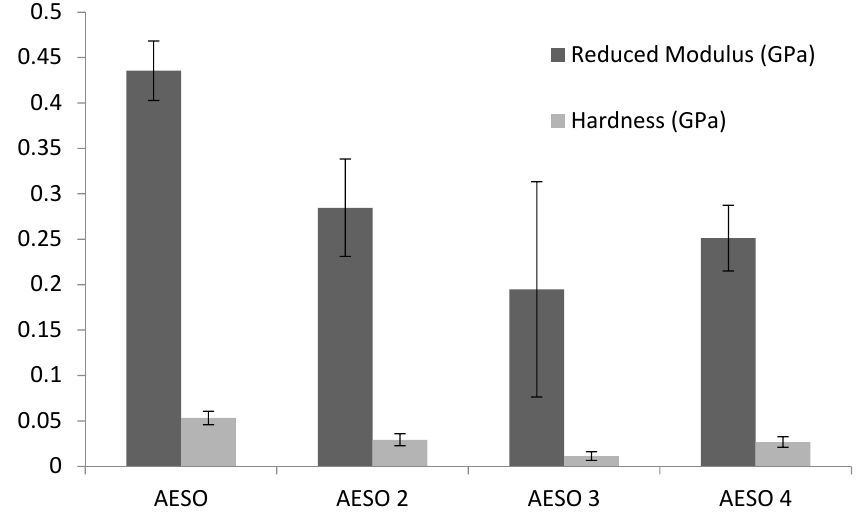
Figure 4. The indentation hardness and reduced modulus for pristine AESO and cellulose-reinforced AESO foams.